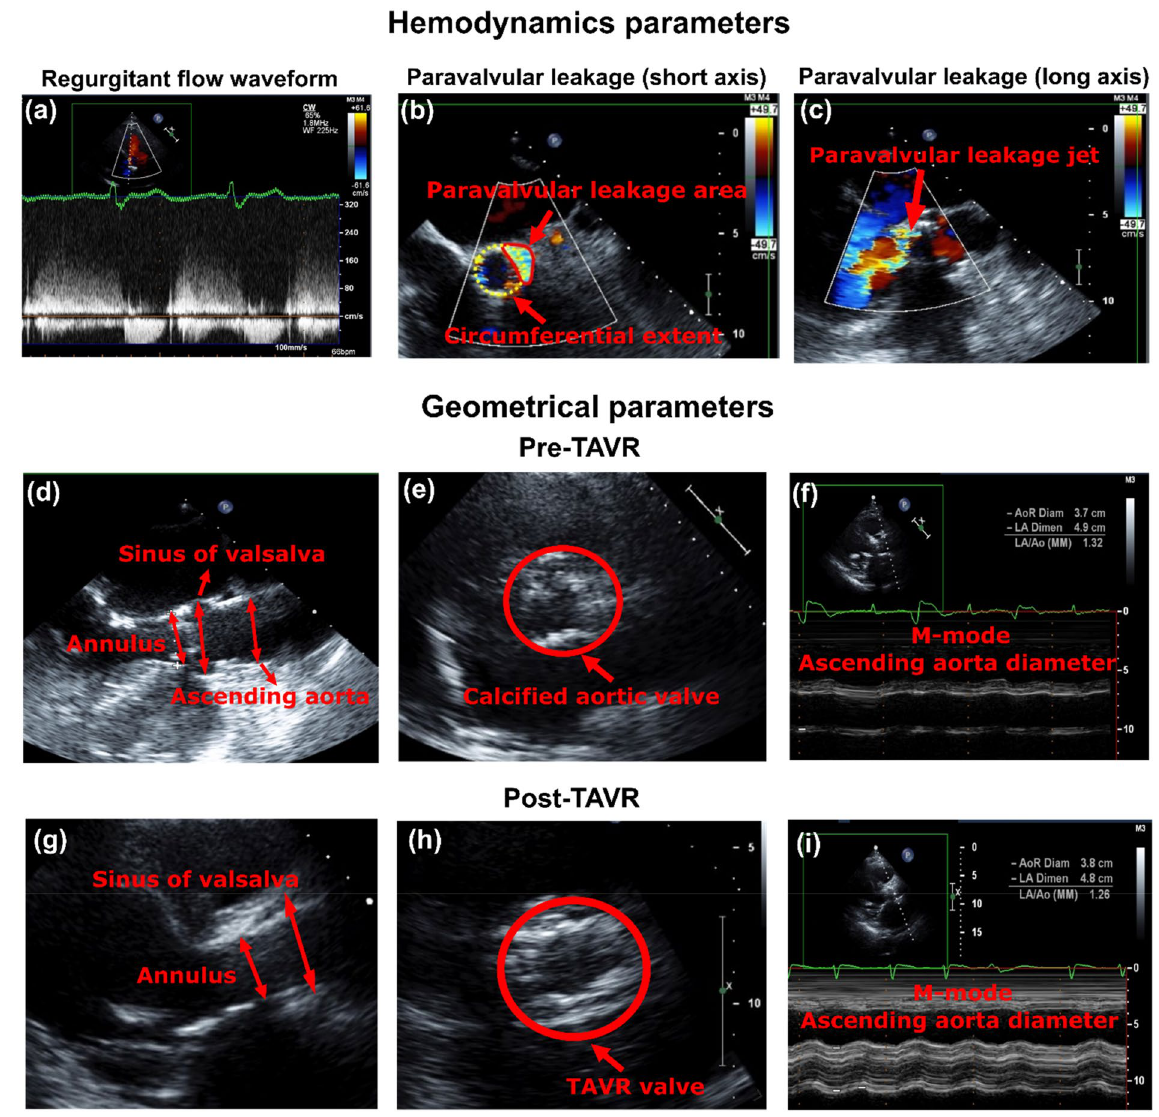
Figure 3. Hemodynamics parameter: ( a ) Regurgitant flow velocity waveform at the paravalvular leakage cite (Apical 5 chamber view); ( b ) Parasternal short-axis color doppler view of the prosthetic valve and the paravalvular leakage area (Vena contracta area: 1.04 cm 2 ) and its circumferential extent with respect to prosthetic valve diameter (35%); ( c ) Long axis color doppler view of paravalvular leakage jet interaction with diastolic flow behind the posterior mitral valve leaflet. Geometrical parameters: ( d ) Parasternal long-axis view associated with different parts of the aortic root and ascending aorta before TAVR; ( e ) Parasternal short-axis view of aortic valve before TAVR; ( f ) M-Mode measurement of ascending aorta before TAVR; ( g ) Parasternal long-axis view associated with different parts of the aortic root, prosthetic frame and ascending aorta after TAVR; ( h ) Parasternal short-axis view of TAVR; ( i ) M-Mode measurement of ascending aorta after